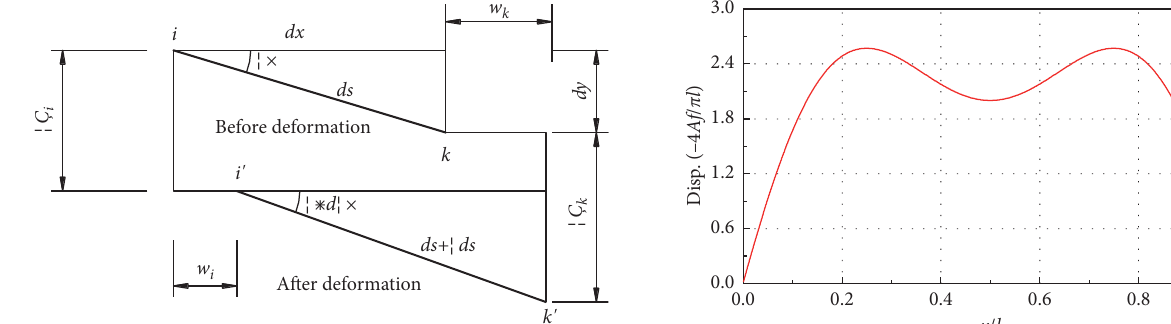
Figure 12: Longitudinal displacement of the main cable under antisymmetric uniformly distributed